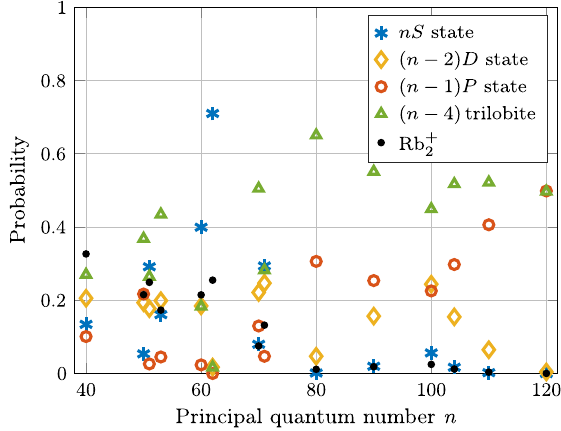
FIG. 5. Theoretical results for the different pathways. Proba- bility to find the Rydberg atom in different states after an ion- neutral collision: S state (blue), P state (red), D state (orange), and in the ð n − 4 Þ trilobite state (green). The Rb þ 2 reaction product will be discussed in the Sec.